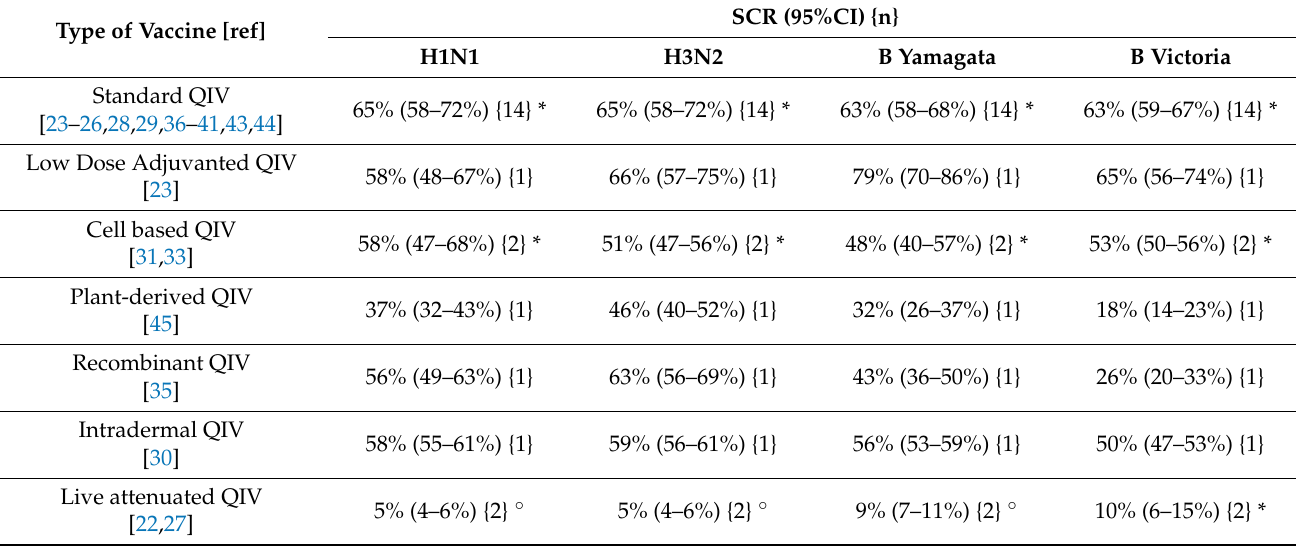
Table 1. Type of vaccine and seroconversion rate (SCR) for the four strains A/H1N1, A/H3N2, B/Yamagata and B/Victoria {Number of studies}.